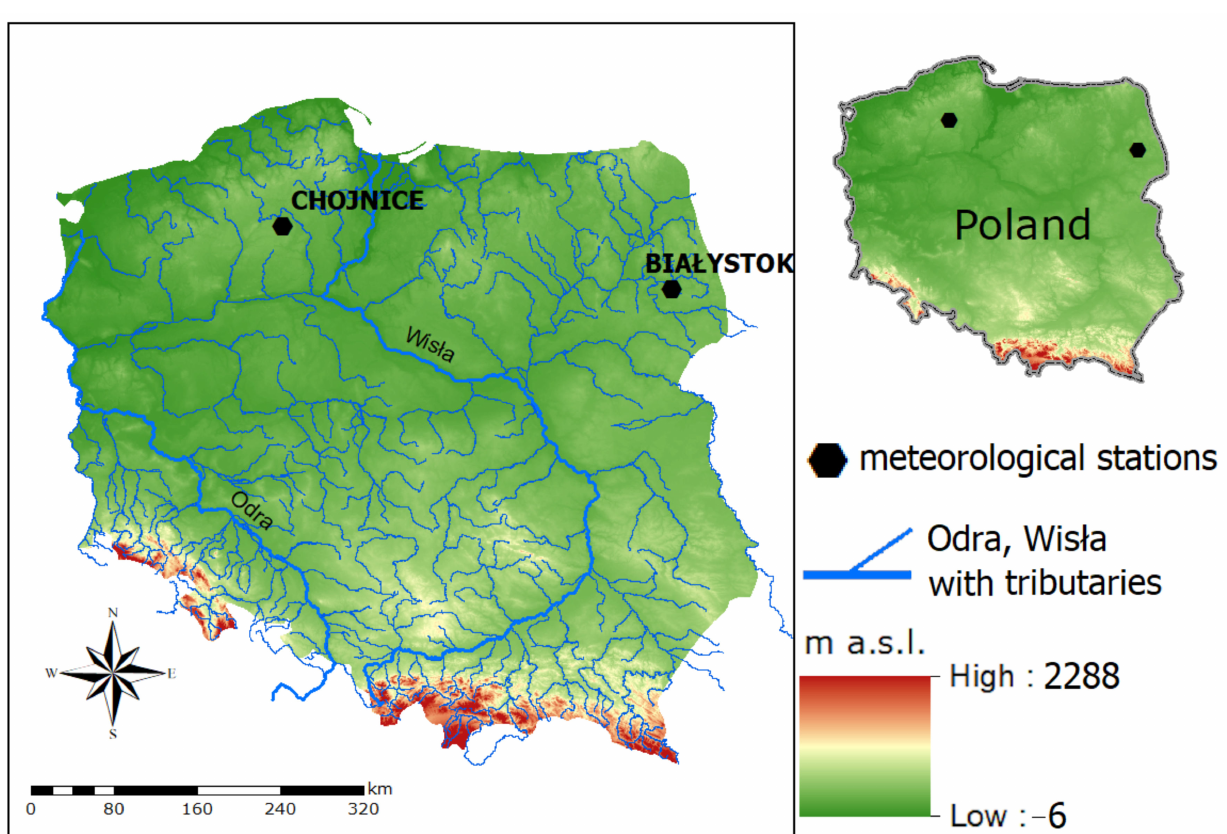
Figure 2. Location of the Chojnice and Bialystok meteorological stations in Poland.